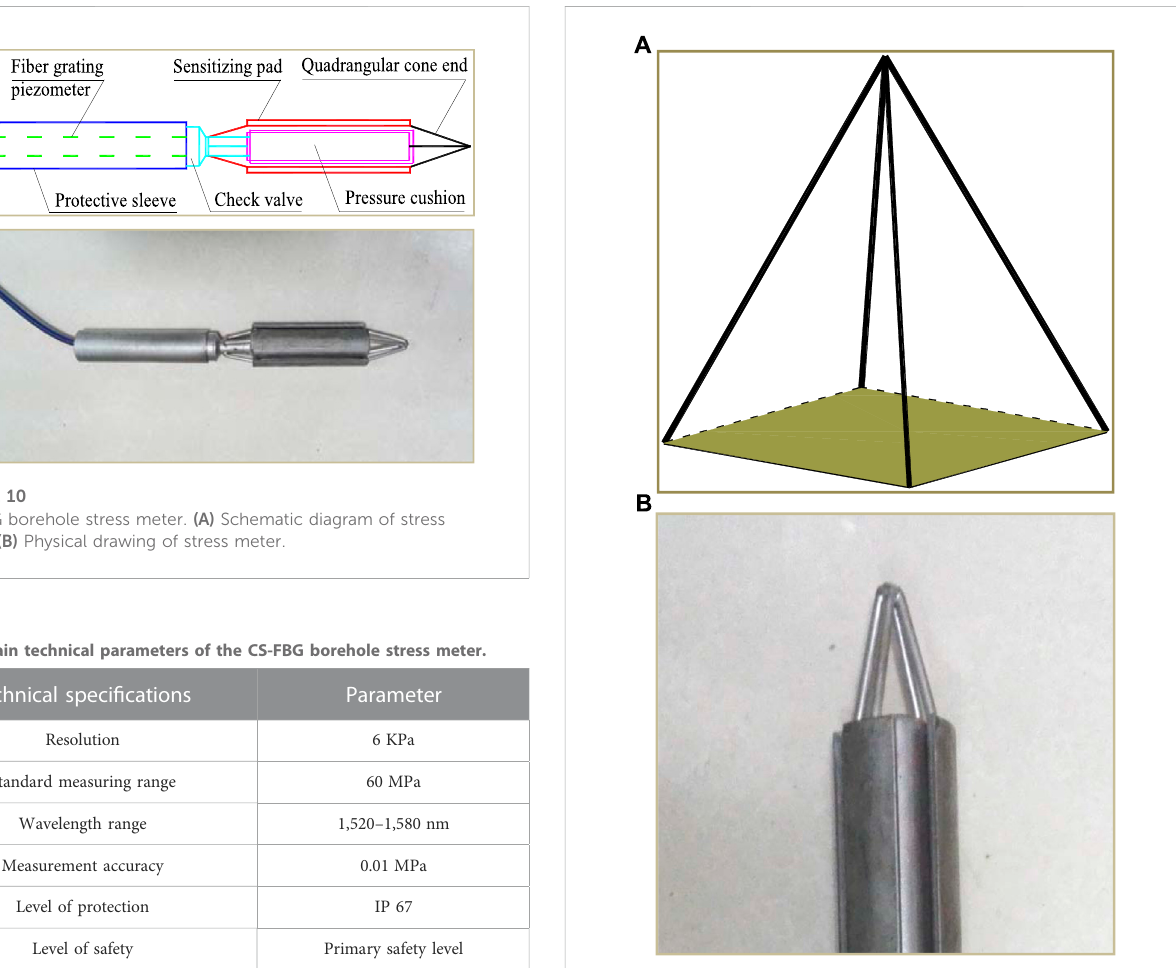
FIGURE 11 Designed pressure-cushion end and sensitizing pad. (A) Quadrangular cone end. (B) End and sensitizing